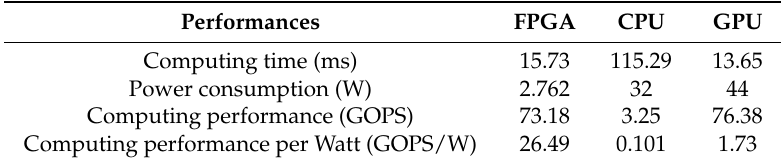
Table 2. Comparison of performance when running on the FPGA, CPU, and